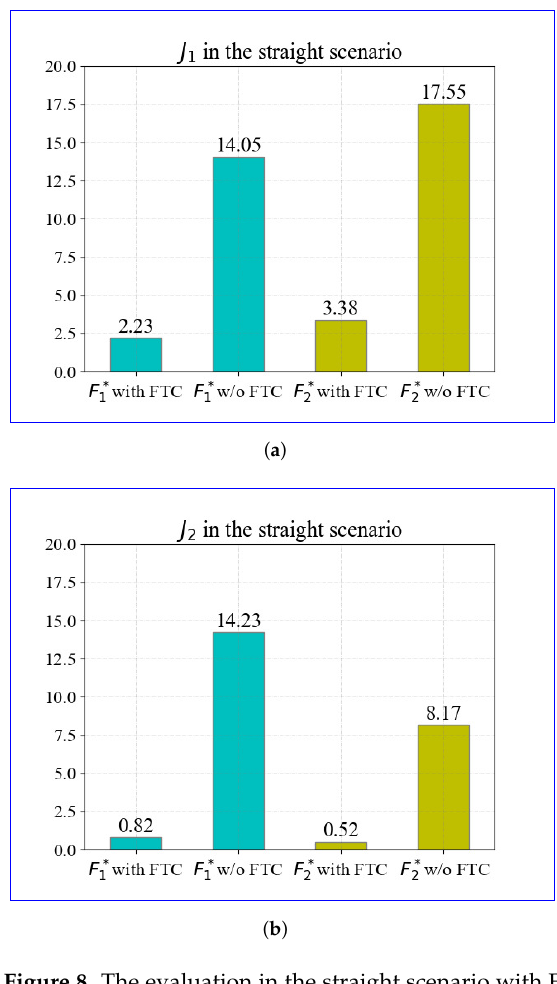
Figure 8. The evaluation in the straight scenario with FTC algorithm and without FTC algorithm: ( a ) J 1 in the straight scenario; ( b ) J 2 in straight